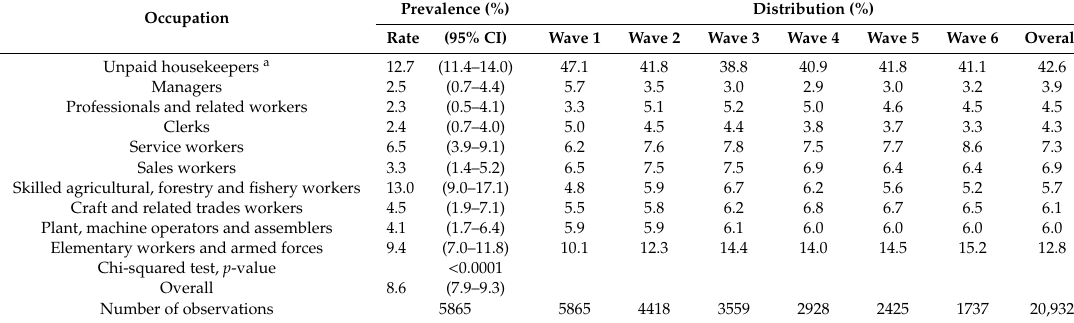
Table 2. The prevalence of cognitive impairment by occupation category at baseline, and the distribution of observations across occupation categories by wave.